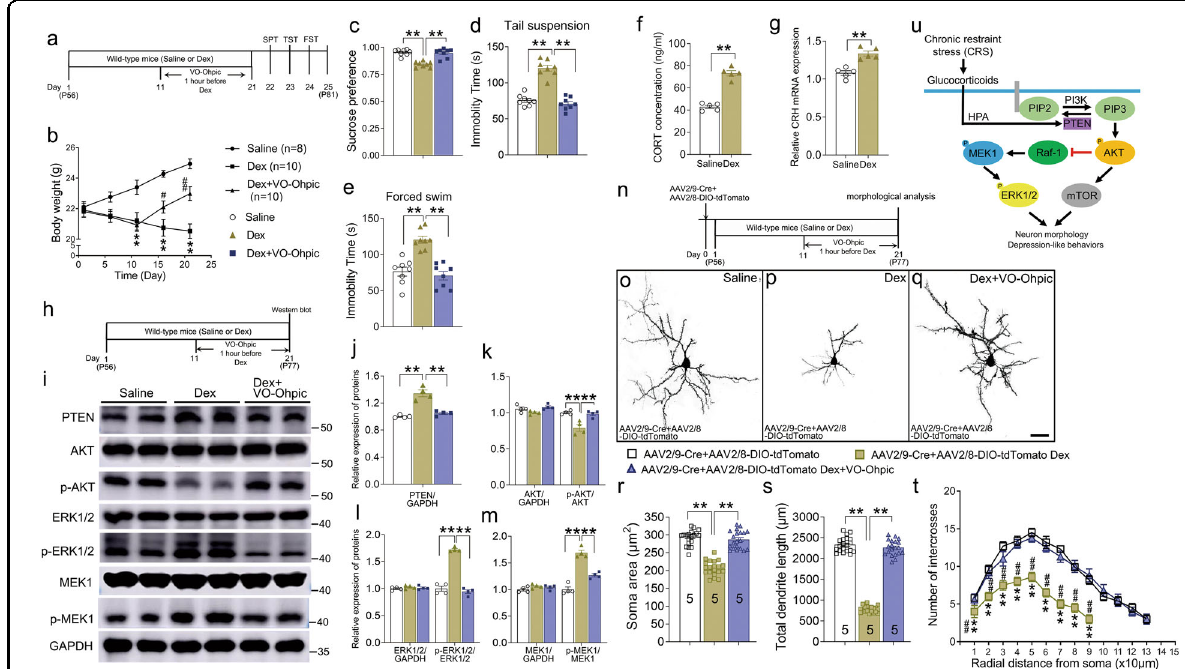
Fig. 5 PTEN inhibitor VO-Ohpic prevents depression-like behaviors and neuron atrophy in Dex-treated mice. a Diagram of experiment design and timeline for ( b – e ). b A signi fi cant reduction in body weight was observed after 21-day Dex treatment, but it could be partially reversed by intraperitoneal injection of VO-Ohpic into the mice starting on day 11. Data were analyzed using two-way repeated measures ANOVA, * p < 0. 05, ** p < 0.01 (Saline versus Dex-treated mice); # p < 0.05, ## p < 0.01 (Dex-treated mice versus Dex-treated mice with VO-Ohpic). c – e Dex resulted in decreased sucrose preference ( c ), and increased immobility time in TST ( d ) and FST ( e ). n = 8 in each group and data were analyzed using one-way ANOVA, ** p < 0.01. f , g The levels of CORT in the serum and CRH transcription in the PFC were increased in Dex-treated mice. Data were analyzed using Student ’ s t -tests, ** p < 0.01. h Diagram of experiment design and timeline for ( i – m ). i – m Three-week Dex treatment led to increased levels of PTEN, p-MEK1, and p-ERK1/2 and reduced level of p-AKT, and these changes were reversed by VO-Ohpic starting on day 11. Note that the levels of ERK1/2, AKT, and MEK1 were not changed by the Dex treatment or application of PTEN inhibitor. n = 4 in each group and data are presented as mean ± SEM. One-way ANOVA ( j ), * p < 0.05, ** p < 0.01. Two-way ANOVA with post hoc Tukey ’ s test ( k – m ), * p < 0.05, ** p < 0.01. n Diagram of experiment design and timeline for ( o – q ). o – q Representative images of pyramidal neuron in layers II/III of PFC neurons of control mice and Dex-treated mice with or without VO- Ohpic administration, respectively. Scale bar = 40 μ m. r – t Statistical data showing the soma size ( r ), total length of dendrites ( s ), and dendritic branching ( t ) of the PFC neurons in indicated groups. n = 20 cells from 5 mice in each group, and all data are presented as mean ± SEM. One-way ANOVA ( r , s ), ** p < 0.01. Two-way ANOVA with post hoc Tukey ’ s test ( t ), * p < 0. 05, ** p < 0.01 (control mice versus Dex-treated mice); # p < 0.05, ## p < 0.01 (Dex-treated mice versus Dex-treated mice with VO-Ohpic). u Model of PTEN signaling pathway in CRS-induced neuronal atrophy and depression-like behaviors. CORT, corticosterone; CRH, corticotropin-releasing hormone; CRS, chronic restraint stress; Dex, dexamethasone; FST, forced swim test; HPA, hypothalamic – pituitary – adrenal axis; OFT, open- fi eld test; SPT, sucrose preference test; TST, tail suspension test; VO-Ohpic, VO-Ohpic